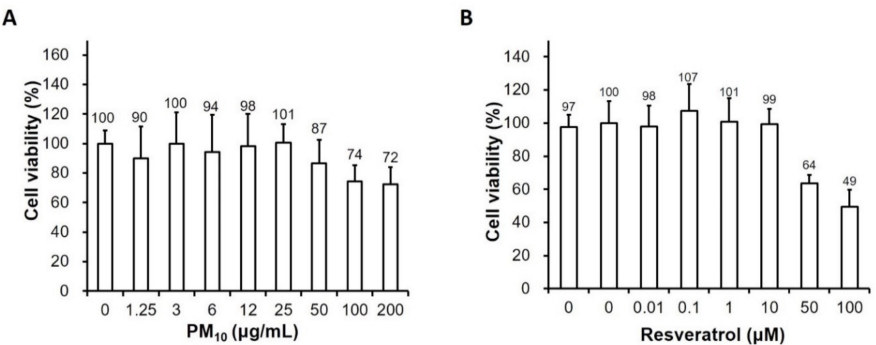
Figure 1. E ff ects of particulate matter and resveratrol on human keratinocyte viability. Viability of keratinocytes treated with ( A ) PM 10 (0, 1.25 µ g / mL, 3 µ g / mL, 6 µ g / mL, 12 µ g / mL, 25 µ g / mL, 50 µ g / mL, 100 µ g / mL, or 200 µ g / cm 2 ) or ( B ) resveratrol (0, 0.01 µ g / mL, 0.1 µ g / mL, 1 µ g / mL, 10 µ g / mL, 50 µ g / mL, or 100 µ M) for 24h measured using the water-soluble tetrazolium salt assay. Data are presented as the mean ± standard deviation of three independent experiments ( n = 3). The ratio of surviving cells is relative to the untreated control. PM, particulate matter.